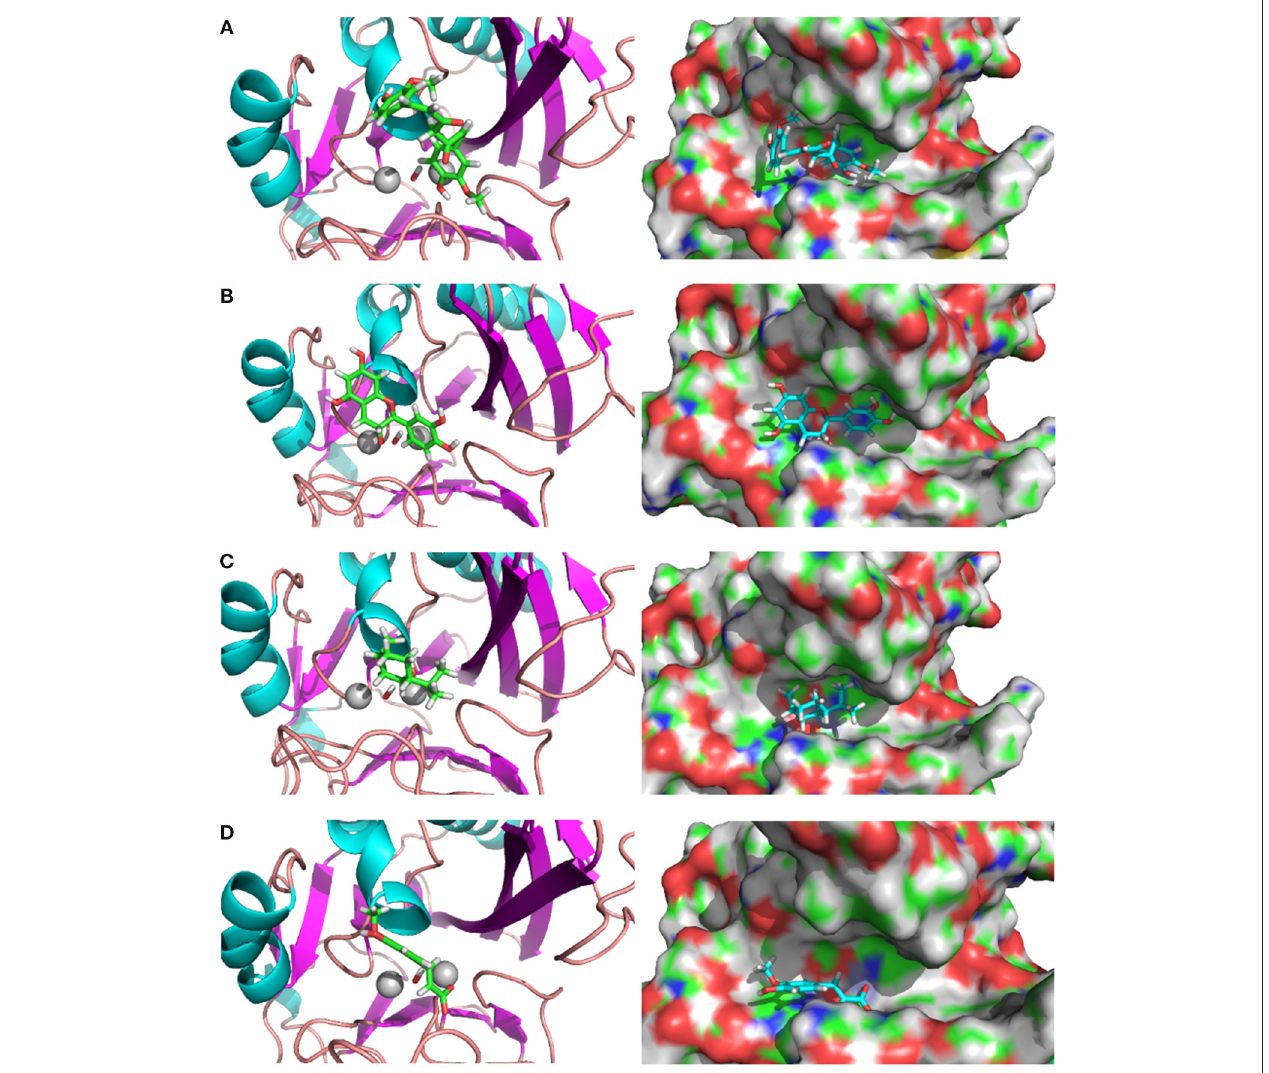
FIGURE 3 | Binding structures of potential inhibitors with the NDM-1 and its location on the surface of NDM-1. (A) Keto form of curcumin; (B) catechin; (C) menthol; (D) Ferulic acid. Figures were prepared using PyMol (Schrodinger, 2012).